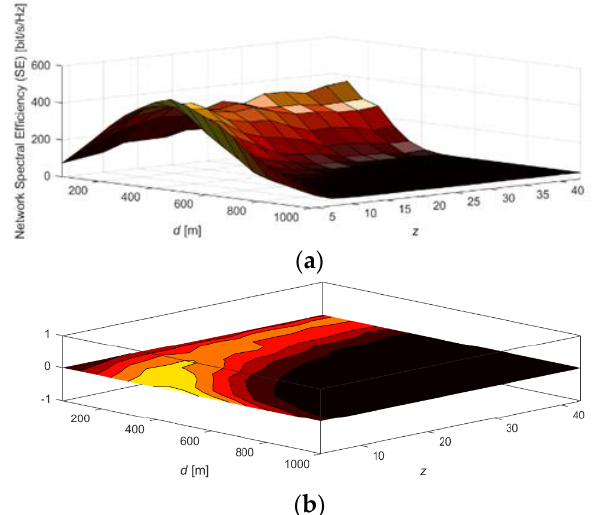
Figure 21. The relationship between the network SE, the maximum allowable D2D distance 𝑑 , and the cache size (i.e., 𝑧 ) of each cache-enabled D2D UE; ( b ) shows a high-angle view of ( a ). 𝑚 is set to be 100 here.